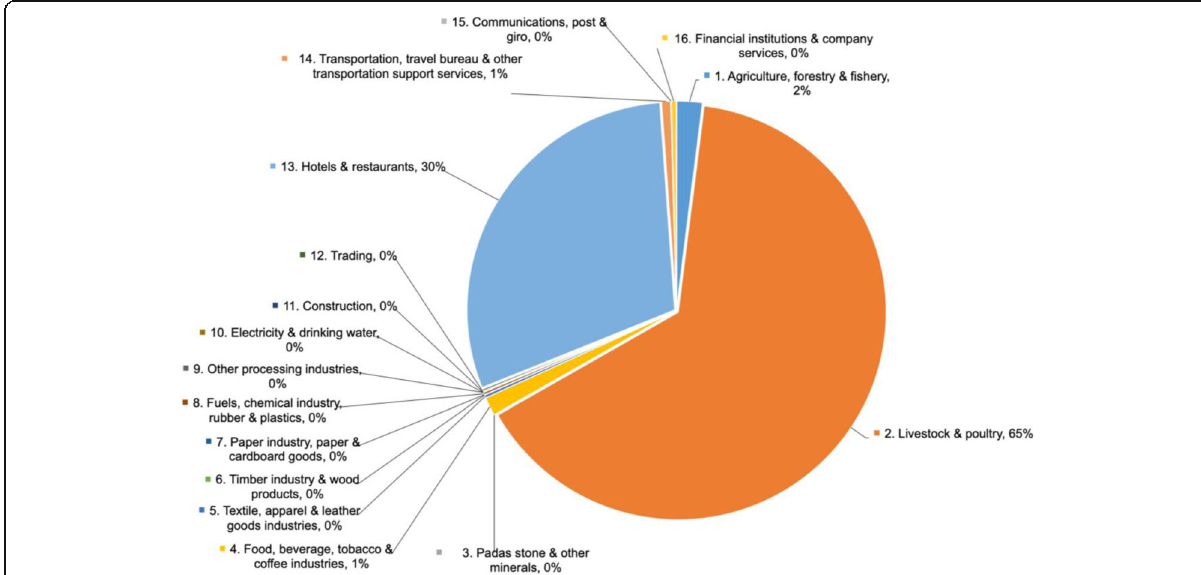
Fig. 5 Indirect BOD discharged by each sector relative to total BOD discharge in the Balinese economy,